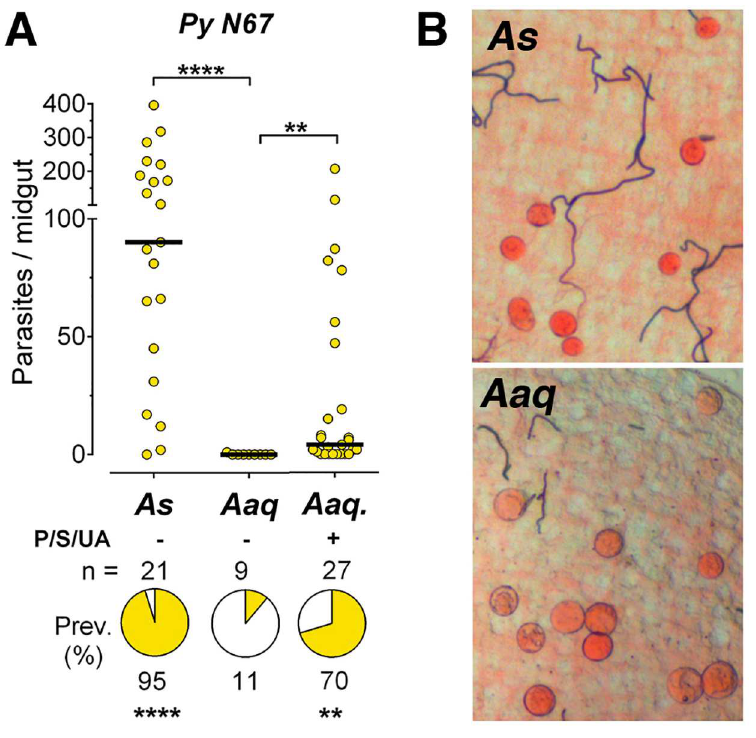
Fig 4. Infection of A . aquasalis with P . yoelii nigeriensis N67 . Susceptibility of Anophelesstephensi ( As ) and Anophelesaquasalis ( Aaq ) mosquitoesto infection with P . yoelii nigeriensis N67 (PyN67). (A) Effect of oral administration of antibiotics (Penicillin/Streptomycin = P/S) and uric acid (UA) on Aaq infection. (B) PyN67 oocysts in As and Aaq mosquitoes8 days post infection. Image of oocysts in Aaq mosquitoestreated with